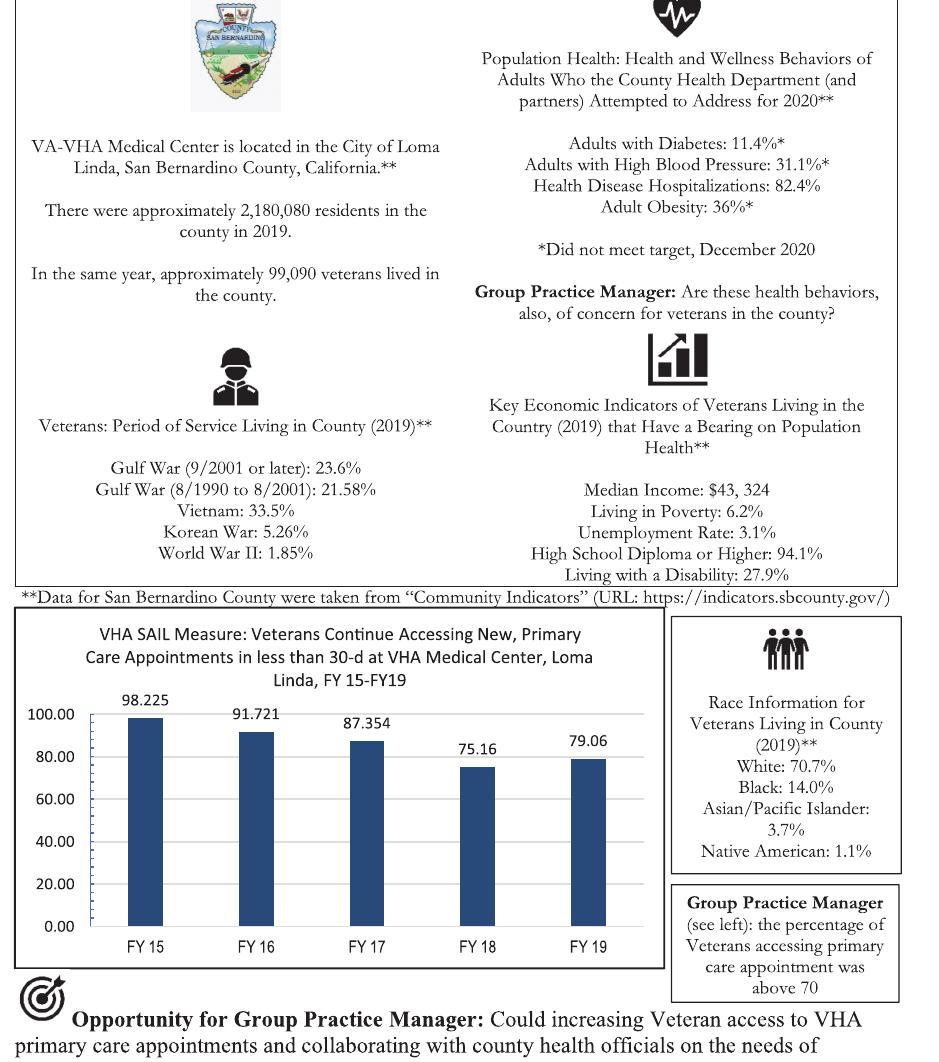
FIGURE 1 (CHARTICLE). Opportunity for VHA Loma Linda Group Practice Managers: Increasing veteran access to primary care appointment while addressing population health for